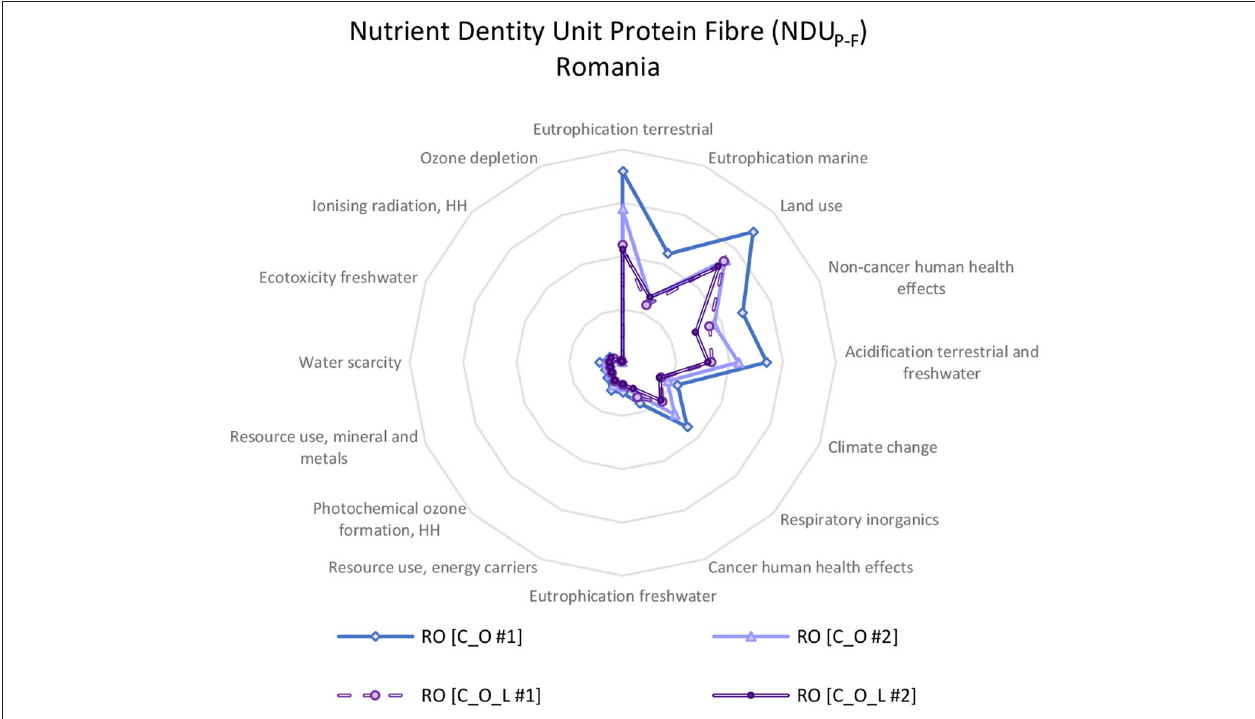
FIGURE 3 | Normalized environmental scores per unit of protein and fiber nutritional output (NDU P − F ) across Romanian crop rotations. RO [C_O #1] refers to cereal-oilseed rotation option 1, RO [C_O #2] refers to cereal-oilseed rotation option 2, RO [C_O_L #1] refers to cereal-oilseed-legume rotation option 1 (with common